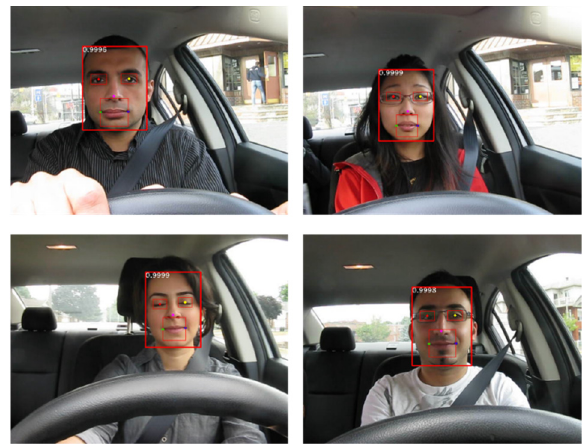
Figure 2. Detection results of Retinaface.